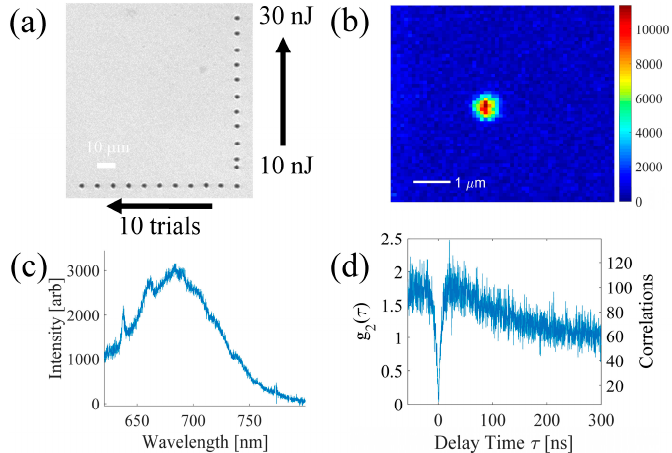
Figure 5. ( a ) Overhead microscope image of the static femtosecond laser exposure area. The black marker spots are written with higher energy and multiple laser pulses to identify the positions of the lower energy single static laser exposures which are not visible. ( b ) Overhead photoluminescence intensity map and ( c ) spectrum for single NV center produced by focused femtosecond laser pulse (24 nJ pulse energy) followed by annealing. ( d ) Intensity autocorrelation (corrected for background on left y -axis [23], raw uncorrected correlations counts on right y -axis) revealing single photon emission.